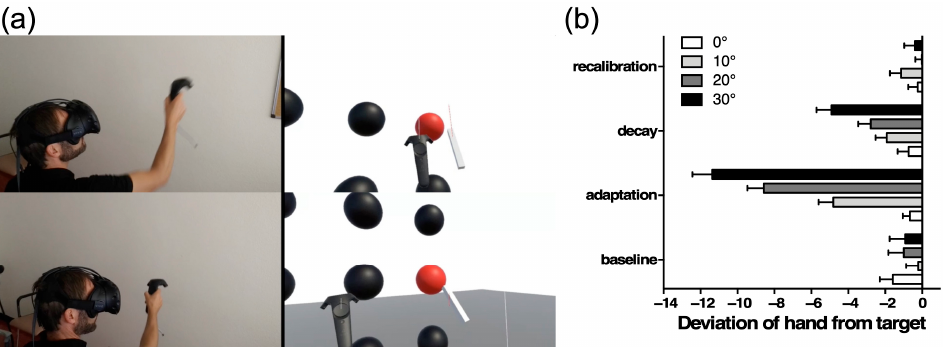
Figure 2. ( a ) Principles of virtual prismatic adaptation. Participants are required to point to the red sphere. Only the white rod is visible for the participant, the image of the controller is only shown here for illustration. Note the increasing mismatch between the controller and the white rod (upper image: 10th trial; lower image: 50th trial), requiring the participant to point further to the left. ( b ) Results of open-loop pointing before (baseline) and after (adaptation) virtual prism adaptation. Note the increasing pointing error with increasing mismatch. Decay was measured after a period of rest, and recalibration indicates performance after pointing without a mismatch [adapted with permission from Ref. 71, 2020, Taylor & Francis] .